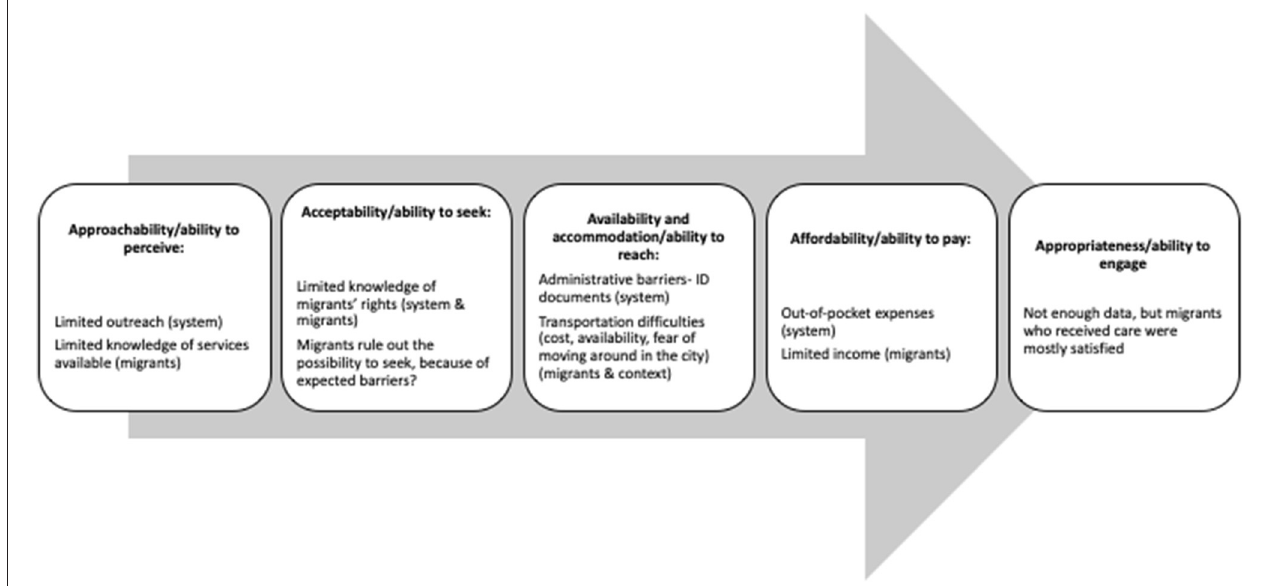
FIGURE 2 | Barriers in the process of accessing health care. 1 Adapted from